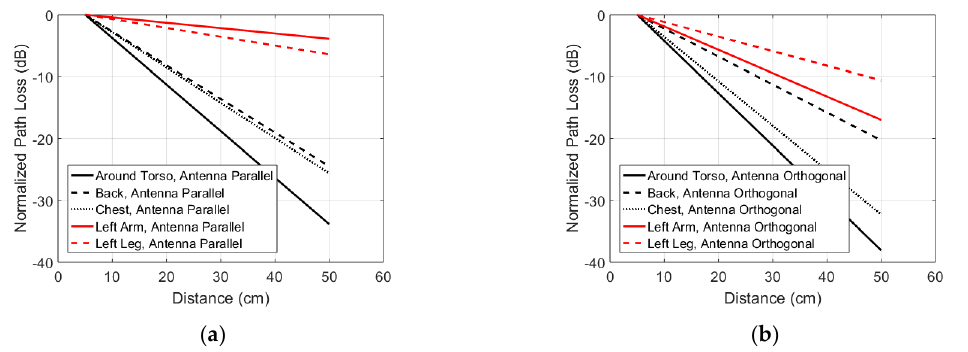
Figure 12. Measured normalized path-loss according to the path loss model described in Equation 2 at 915 MHz in five different on-body scenarios for ( a ) folded dipole antennas parallel to the body and ( b ) folded dipole antennas orthogonal to the body. Table 3. Parameters of the path loss model shown in Equations (1) and (2) for five scenarios and two studied antenna configurations at 915 MHz. Antenna Parallel Antenna Parallel